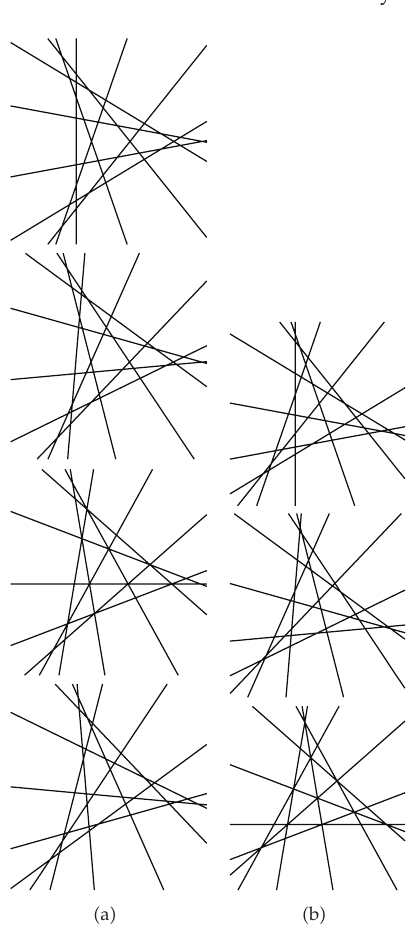
Figure 2: Simple and simplicial arrangements for d (cid:8) 9 (cid:6) a (cid:7) n (cid:8) 0 (cid:6)Σ 1 (cid:7) , 1 , 2 (cid:6) S D (cid:7) , 3, (cid:6) b (cid:7) n (cid:8) 4 (cid:6)Σ 2 (cid:7) , 5 , 6 (cid:6) S B (cid:7)